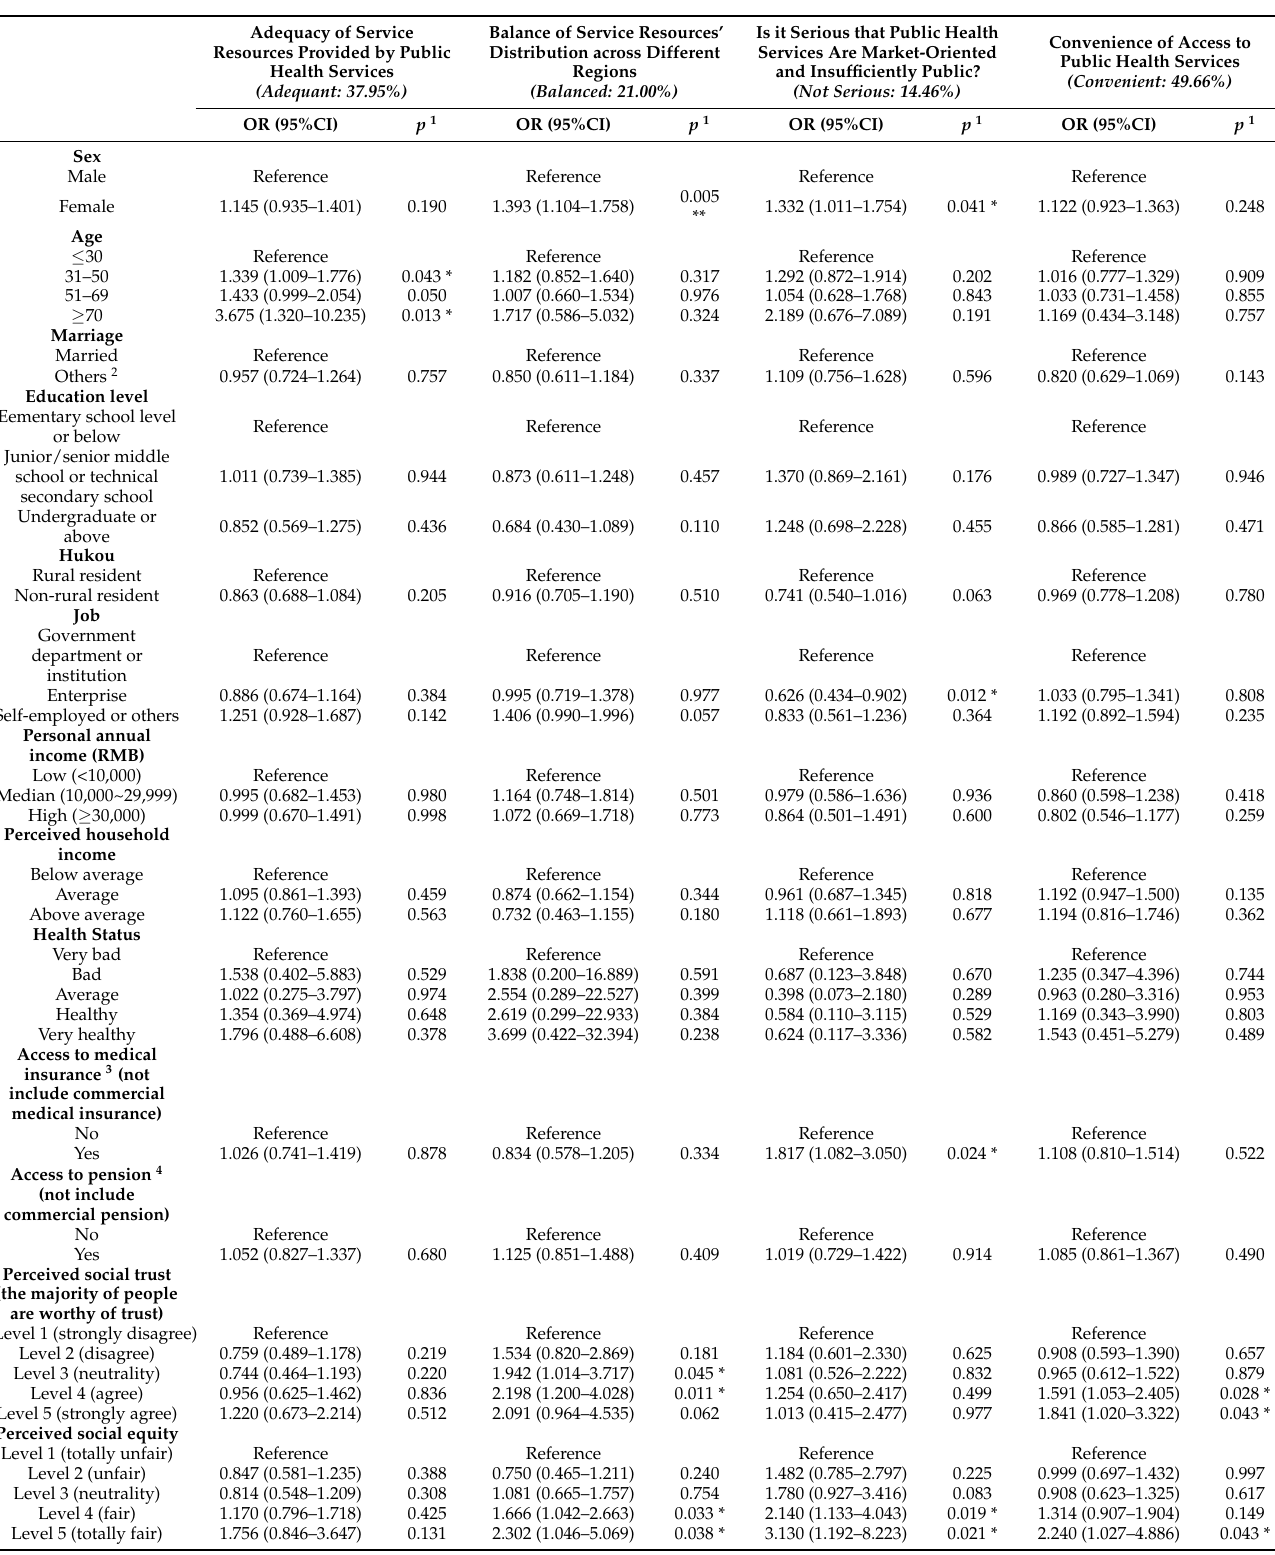
Table 2. Binary Logistic Regression Model of Respondents’ Sociodemographic Characteristics and Service resource evaluation among CGSS